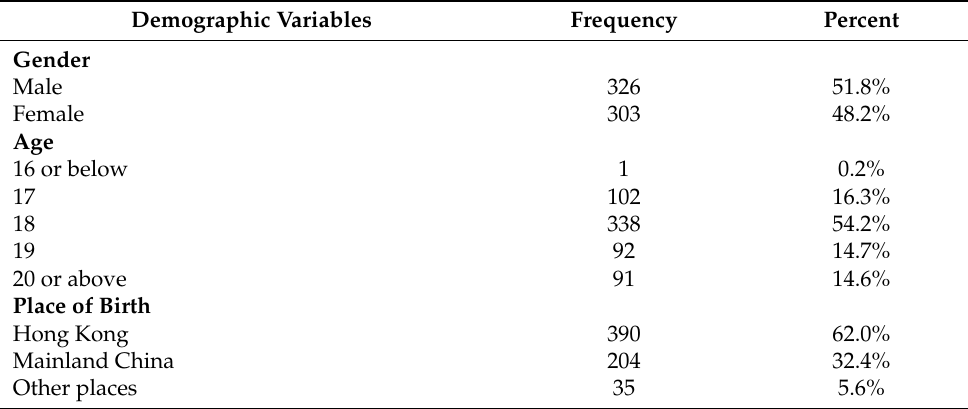
Table 1. Demographic information of participants ( n =